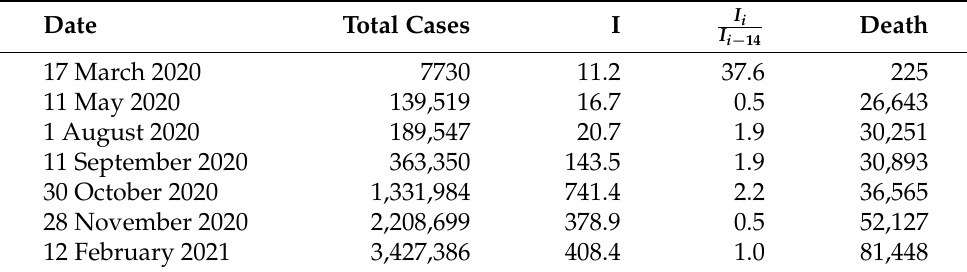
Table 1. Data for France: Total cases, Cases per 100,000 inhabitants in the last 14 days, rate of Cases in the last 14 days and the previous 14 days interval, Death related to